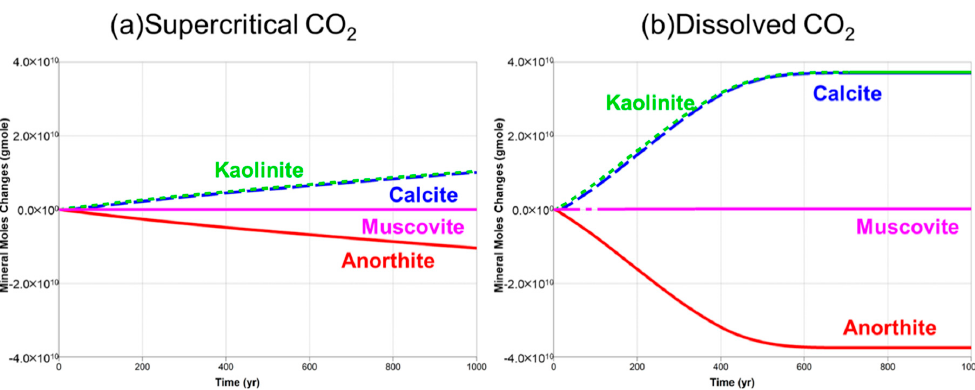
Figure 16. Comparison of evolutions of kaolinite, calcite, muscovite, and anorthite between scenarios.